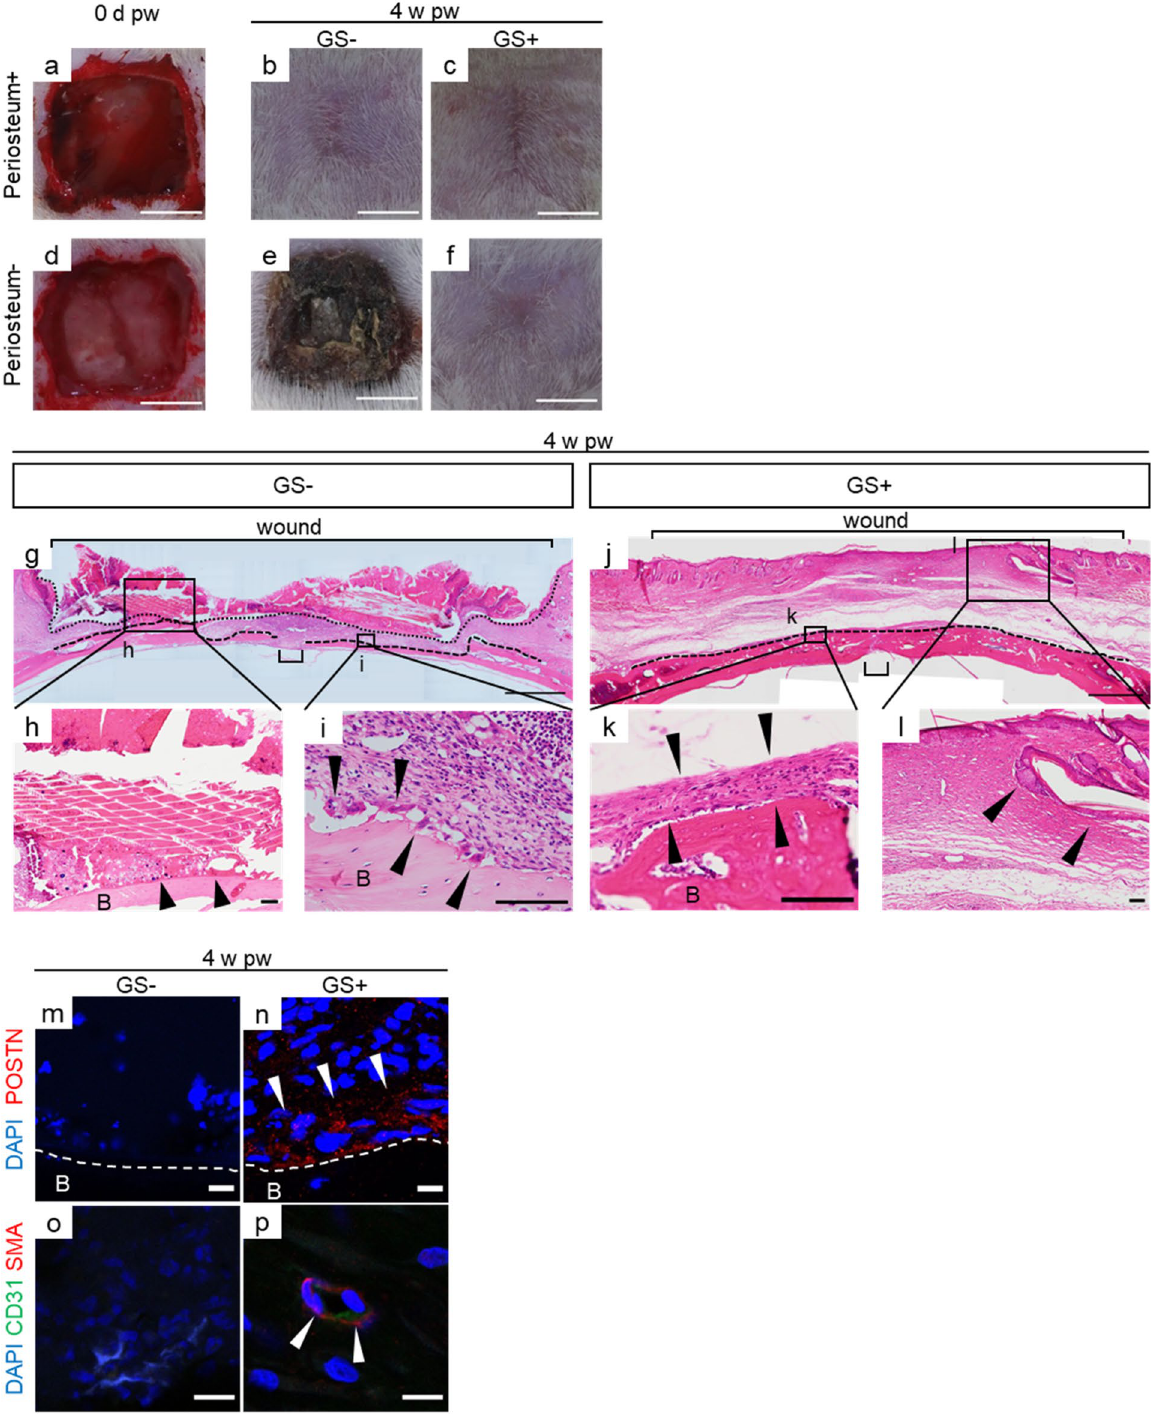
Figure 1. GS allows regeneration of heterogeneous tissues in deep wounds with exposed bone cortex. ( a – f ) Gross appearance of skin/subcutaneous defects with/without periosteum defects when GS is applied or not is shown after manipulation (0 d pw) and at 4 weeks pw. ( g – l ) H&E staining of deep wounds with periosteal defects at 4 pw is shown. A high-power view reveals the invasion of immune cells into the bone cortex in open wounds ( h , i , arrowheads), while membranous structures and hair follicles are present in GS-treated wounds ( k , l arrowheads). ( m – p ) Periostin (red), a marker of the periosteum, is positive in membranous structures and cavity structures with smooth muscle actin (red), and CD31 positivity (green) is present in the GS-treated wounds. n = 4 for each. The experiments were repeated twice. Scale bars, 5 mm in ( a – f ), 1 mm in ( g , j ), 100 μm in ( h, i, k, l ), 10 μm in ( m – p ). d day, w week, pw post-wounding, GS − open wound, GS + GS-treated wound, B bone. Wound with brackets in ( g ) and ( j ), the regions excised at the beginning; dotted line, the apical boundary; dashed lines, the surface of bone cortex; DAPI 4 ′ 6-diamidino-2-phenylindone, POSTIN periostin, SMA smooth muscle